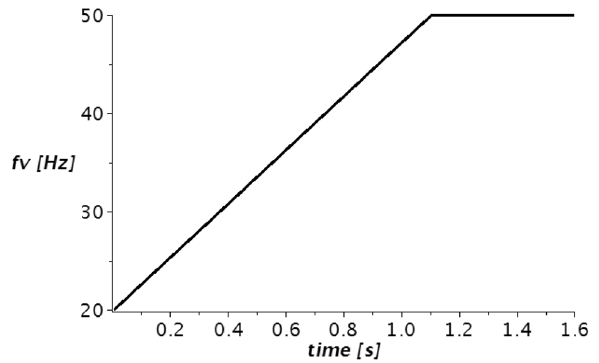
Fig. 25 Rotational speed of the motor during the frequency start- ing with the linear frequency increase